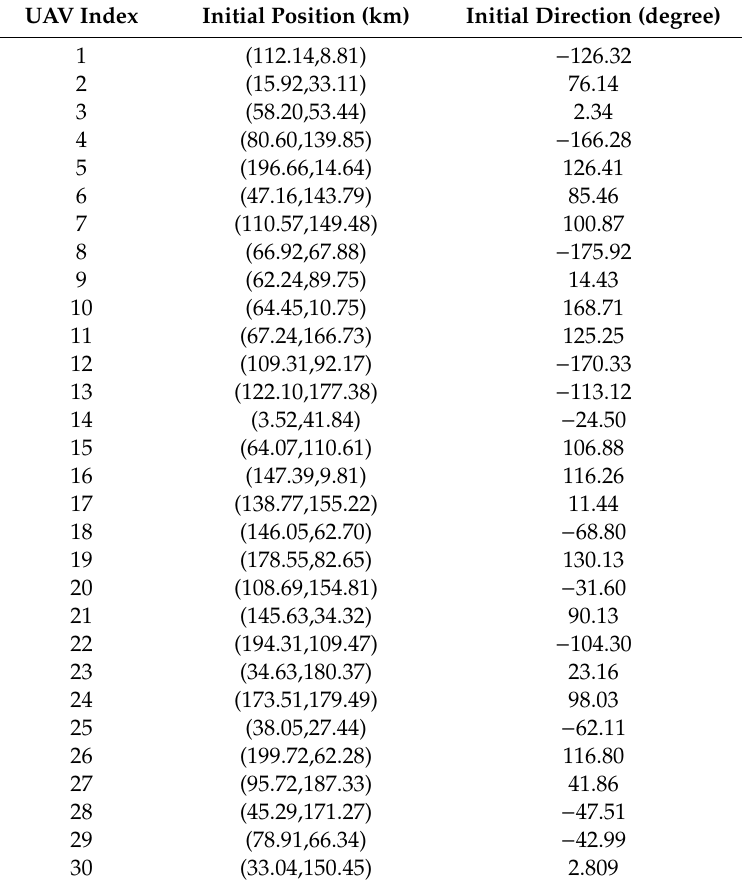
Table 4. Initial settings of UAVs.